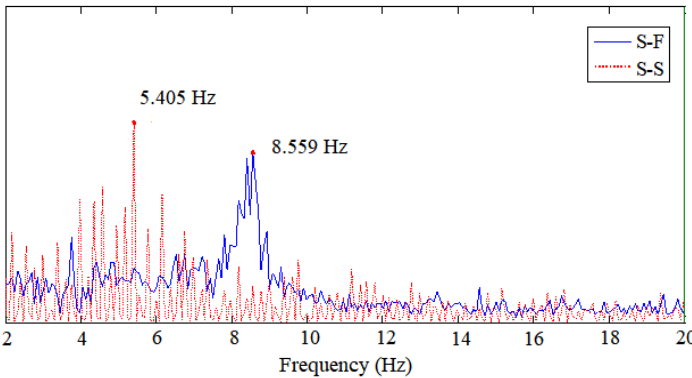
Figure 9. PSD of the UPVC risers with two different end conditions (U = 1.0 m/s).